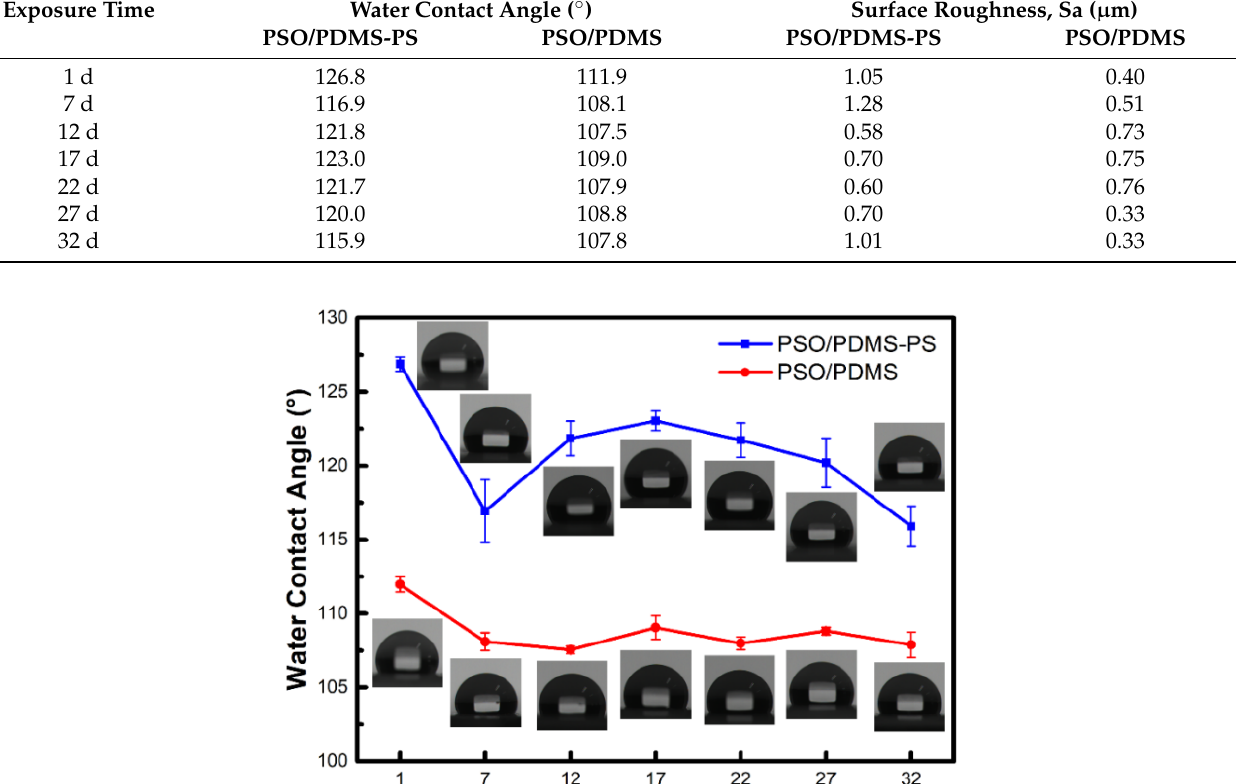
Table 1. The surface properties of the samples. The exposure time for PSO leaching from composite coatings. Exposure Time